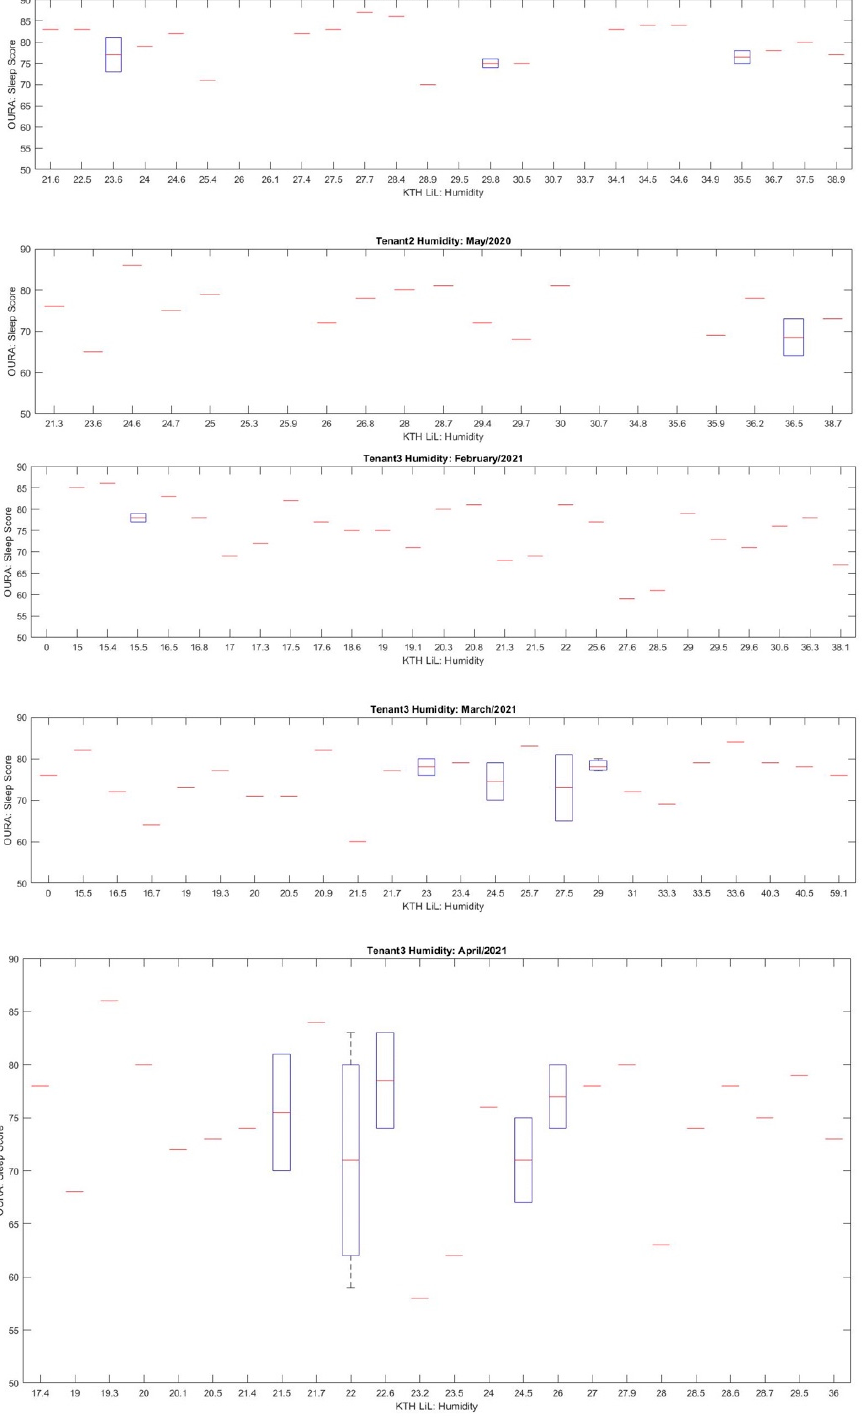
Figure 9. Sleep score vs. relative humidity.